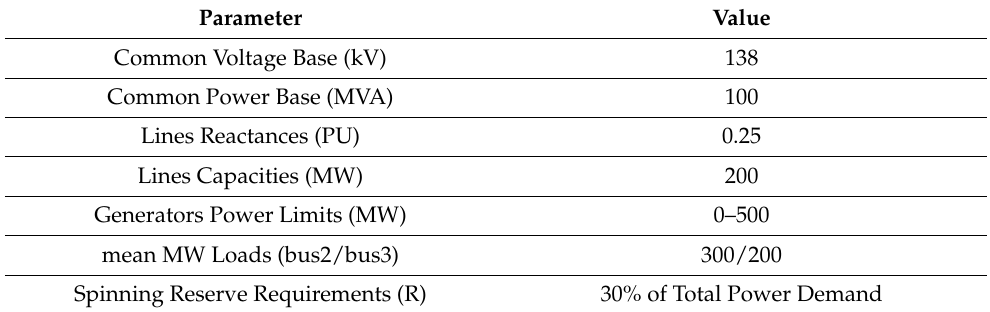
Figure 8. System Diagram (4-Bus System). Table 1. System Data (4-Bus